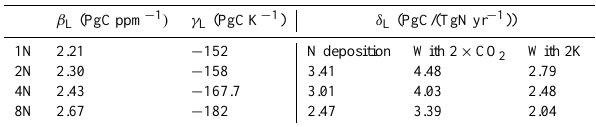
Table 2. Terrestrial ecosystem carbon (TEC) sensitivity to CO 2 fertilization ( β L ) and its changes under increasing N deposition, TEC sensitivity to warming ( γ L ) and its changes under increasing N deposition and TEC sensitivity to nitrogen deposition ( δ L ) and its changes under increasing CO 2 concentration and warming. The pairs of experiments used to calculate the sensitivities are shown in Fig.